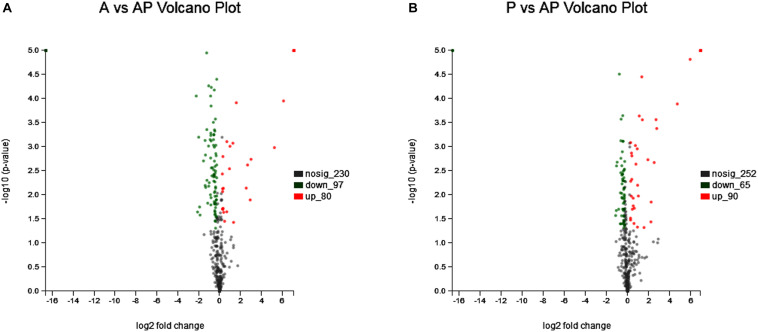
Volcanic map of all identified proteins: (A) volcanic map of all identified proteins in A vs. AP; (B) volcanic map of all identified proteins in P vs. AP. Red points: up-regulated proteins (fold change > 1.2, p < 0.05); green points: down-regulated proteins (fold change > 0.83, p < 0.05); black points: unchanged proteins.